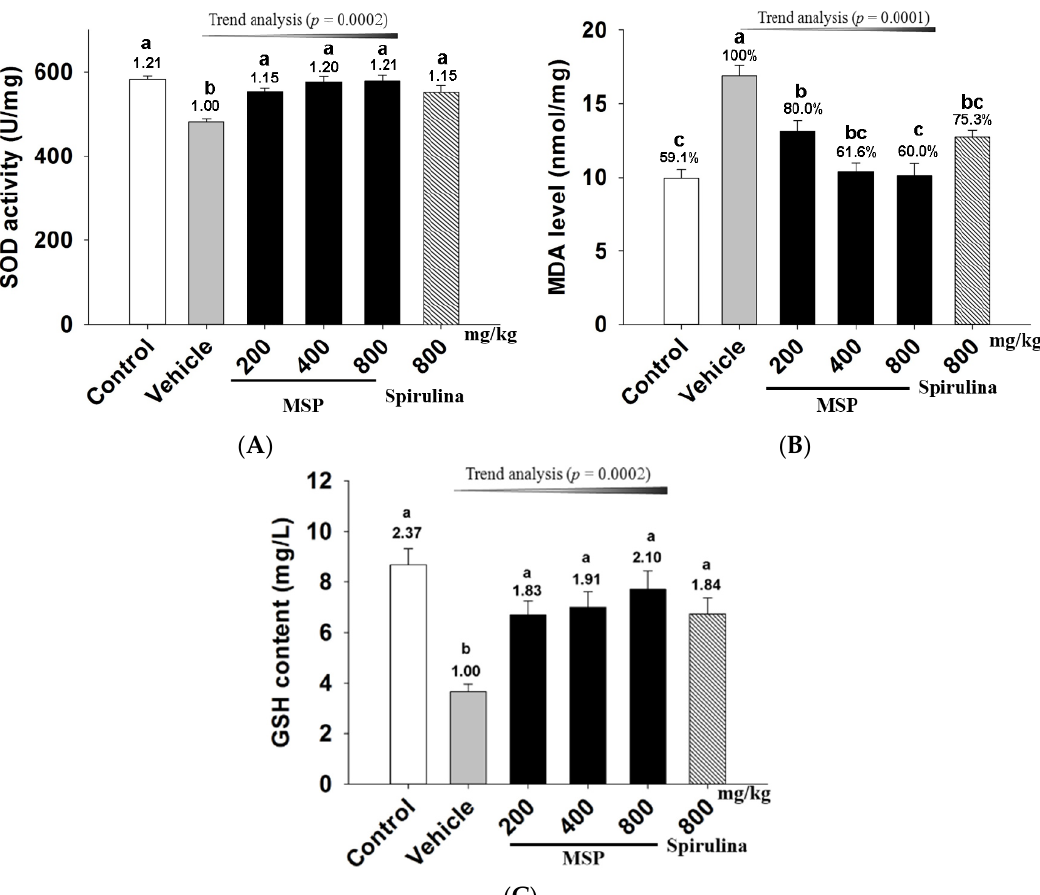
Figure 5. Effects of Millettiae speciosae Champ. total polysaccharides (MSP) on the plasma superoxide dismutase (SOD) activity ( A ); malondialdehyde (MDA) level ( B ) and glutathione (GSH) level ( C ) in mice after swimming for 30 min. Control group (open column), vehicle group (grey column), MSP ‐ treated group (200,400, 800 mg/kg/day, black column), spirulina group (800 mg/kg/day, twill column). Data are mean ±standard error of the mean (SEM) with n = 8 mice per group. Bars with different letters (a,b) are significant difference at p < 0.05. Numbers above the bars are the fold increase compared to the vehicle treatment.